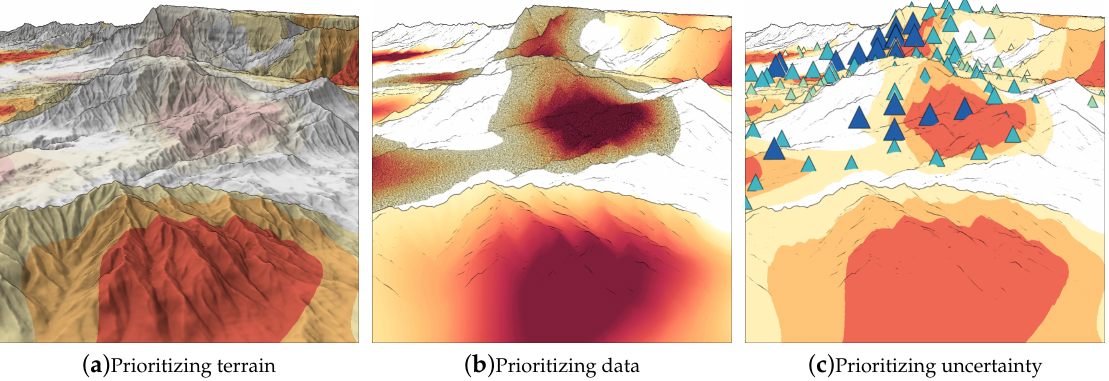
Figure 5. Differently prioritized visual representations of the same terrain, data, and uncertainty. ( a ) The terrain is prioritized and rendered as a detailed shaded surface. The data are visualized in an aggregated fashion by a segmented color scale, and uncertainty is depicted intrinsically by using transparency; ( b ) The data are prioritized and individual values are visualized with a continuous color scale. The terrain is rendered at less detail by drawing only lines, and uncertainty is depicted intrinsically by using noise; ( c ) Uncertainty is prioritized and depicted extrinsically via colored triangular glyphs. The terrain is rendered at less detail as in ( b ), and the data are visualized in an aggregated fashion as in ( a